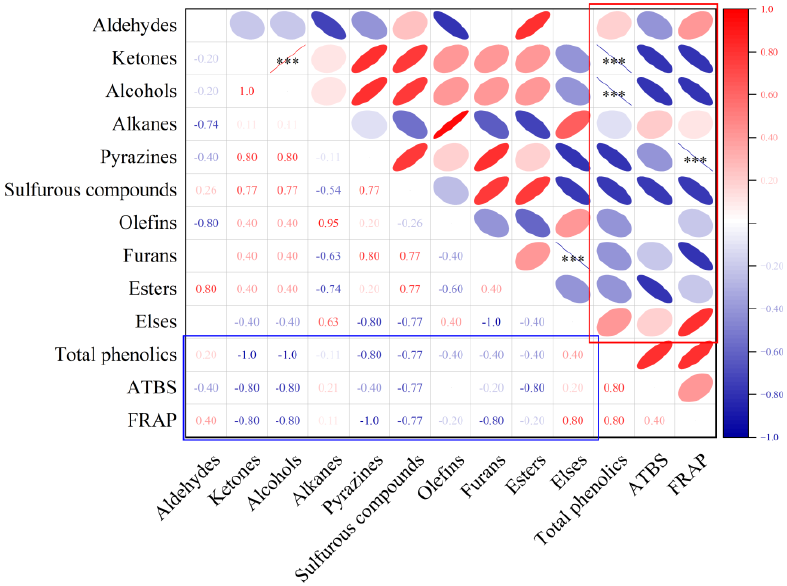
Figure 6. Correlation between volatile compounds and antioxidative abilities of spices. (*** =0.001 level).